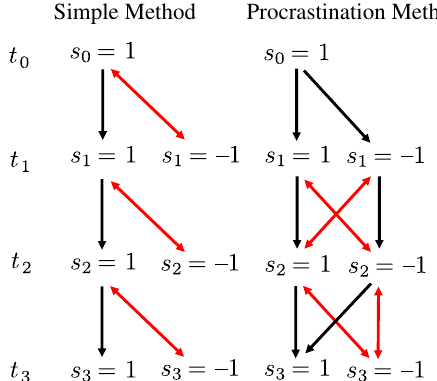
FIG. 7. The above flowchart outlines the two methods of using forced measurement or its generalizations for recovery protocols, as discussed in the text. The one-directional arrows (black) indicate a process that yields a desired or acceptable outcome for which we do not apply a recovery protocol. The bidirectional arrows (red) indicate a process that yields an undesired or unacceptable outcome for which we apply a recovery protocol. We can schematically think of the recovery protocol as back- tracking and trying the process again, with a new probability of obtaining a desired outcome. The simple method applies a recovery protocol whenever a turning point measurement out- come indicates that a diabatic transition occurred to an excited state. The procrastination method will accept either measurement outcome at the first turning point. However, when the first measurement outcome is s 1 ¼ − 1 , if we procrastinate, we must require the second turning point to have measurement outcome s 2 ¼ − 1 because we need two wrongs to make a right.